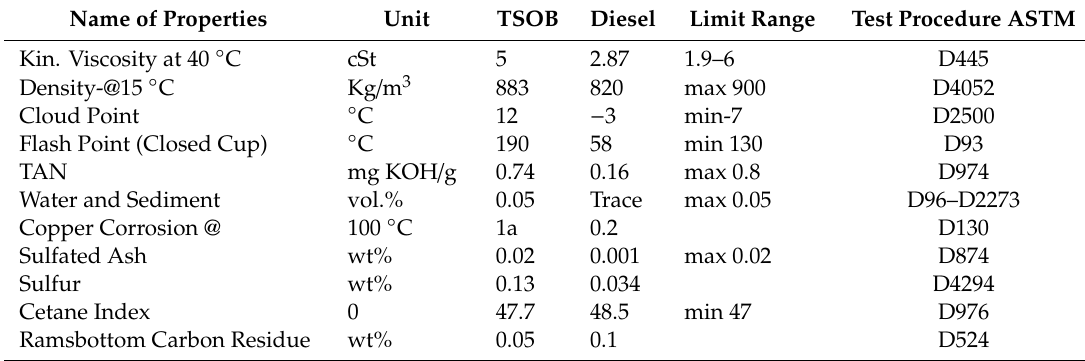
Specifications of diesel and tomato seed oil biodiesel (TSOB) in accordance with ASTM